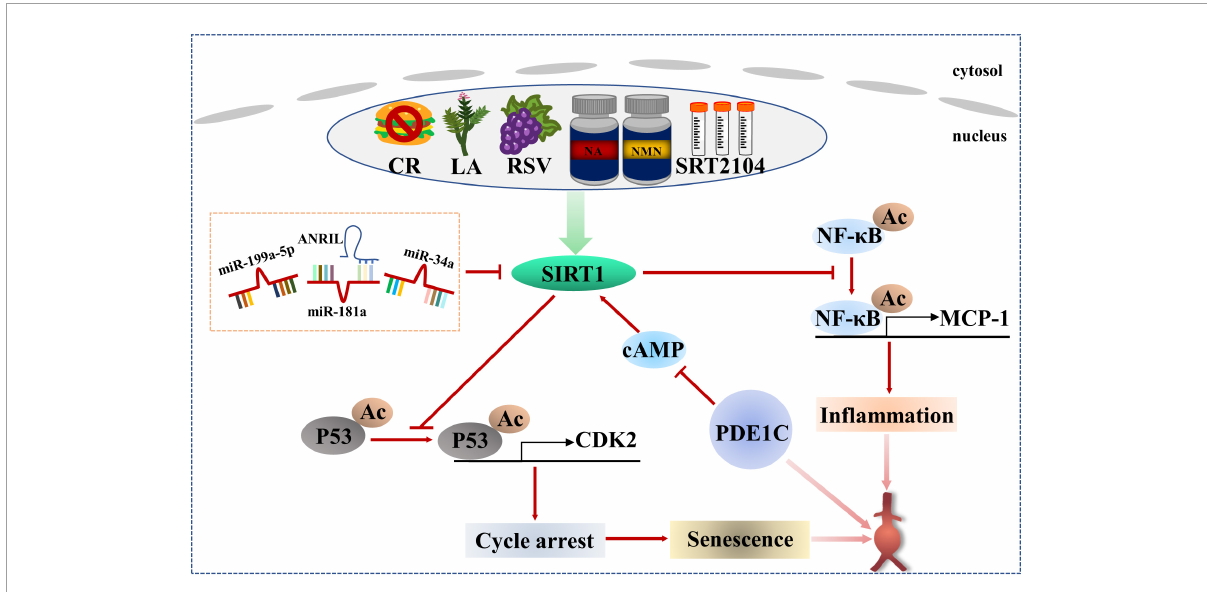
FIGURE3 Regulation mechanism and intervention between SIRT1-related senescence and